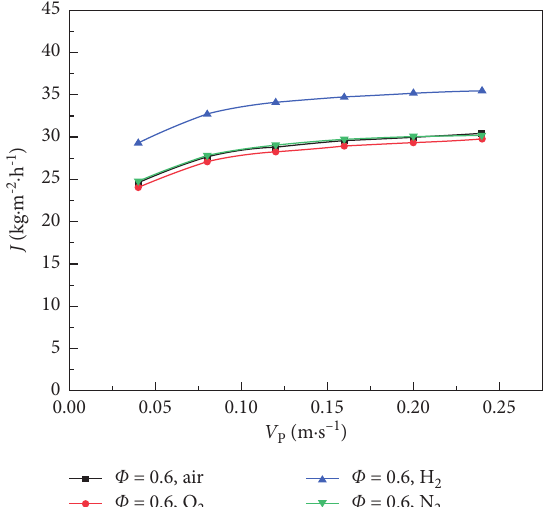
� 333K, T � 293K, V � 0.145m/s, P � P F,in P,in F,in F 0 ,